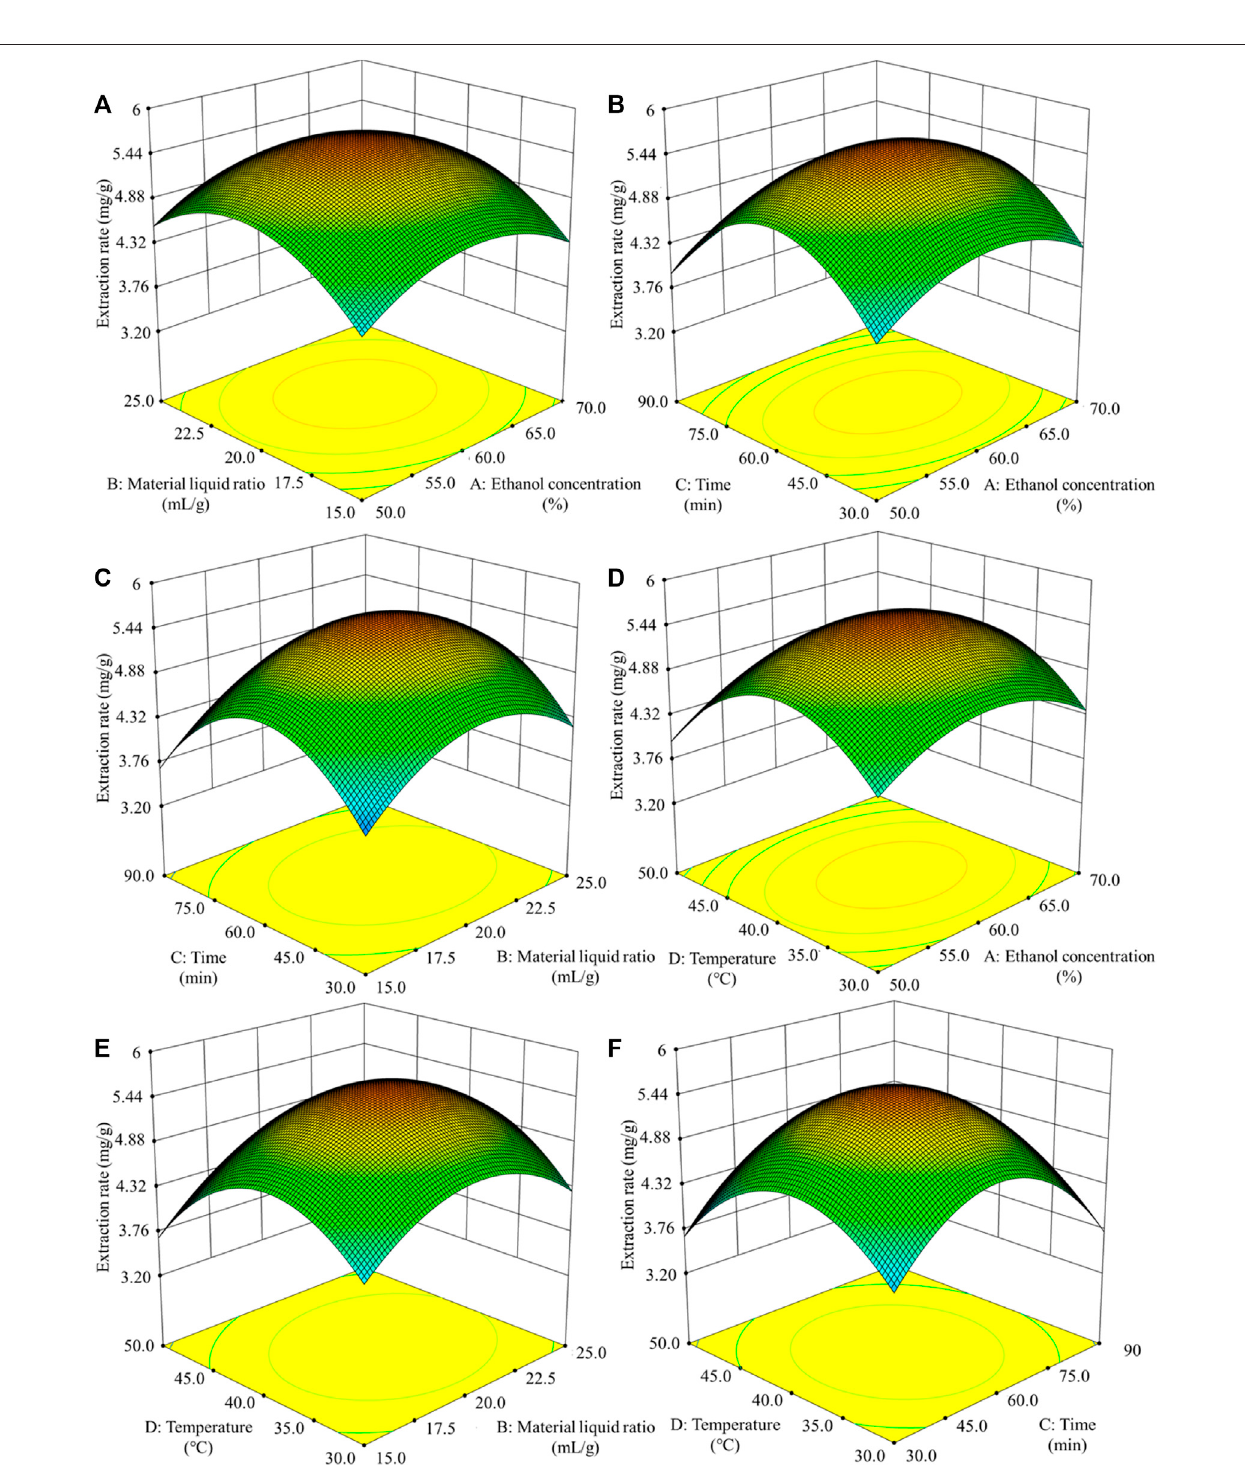
FIGURE2| Responsesurfacecurveofthein fl uenceoftheinteractionofvariousfactorsontheextractionrateofpolyphenols (A) displaysthein fl uenceofsolid-liquid ratio and ethanol concentration on extraction rate (B) displays the in fl uence of extraction time and ethanol concentration on extraction rate (C) displays the in fl uence of extraction time and solid-liquid ratio on extraction rate (D) displays the in fl uence of extraction temperature and ethanol concentration on extraction rate (E) displays the in fl uenceofextractiontemperatureandsolid-liquidratioonextractionrate (F) displaysthein fl uenceofextractiontemperatureandextractiontimeonextractionrate.